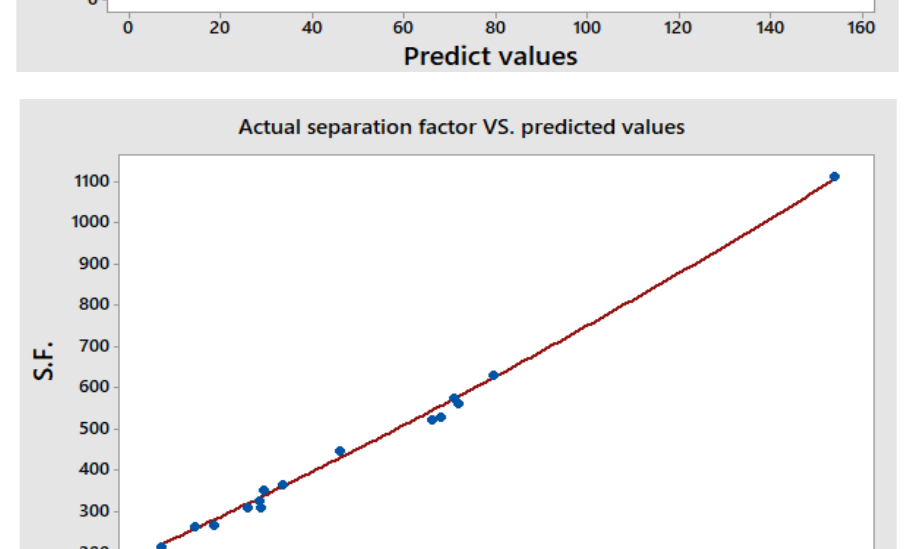
different factors. Moreover, the ANOVA test helps determine the significance or non- significance of the results of an experiment. It is possible to calculate the sum of square (SS), which is equal to Σ ( x − y ) 2 , where ( x ) is equal to the sum of measurement data divided by the number of experiments and ( y ) is measurement data. The mean square is equal to (SS) divided by the degree of freedom (DF), F values are the ratio of the mean square to the true error, and p value is the probability of obtaining at least one statistic test. The